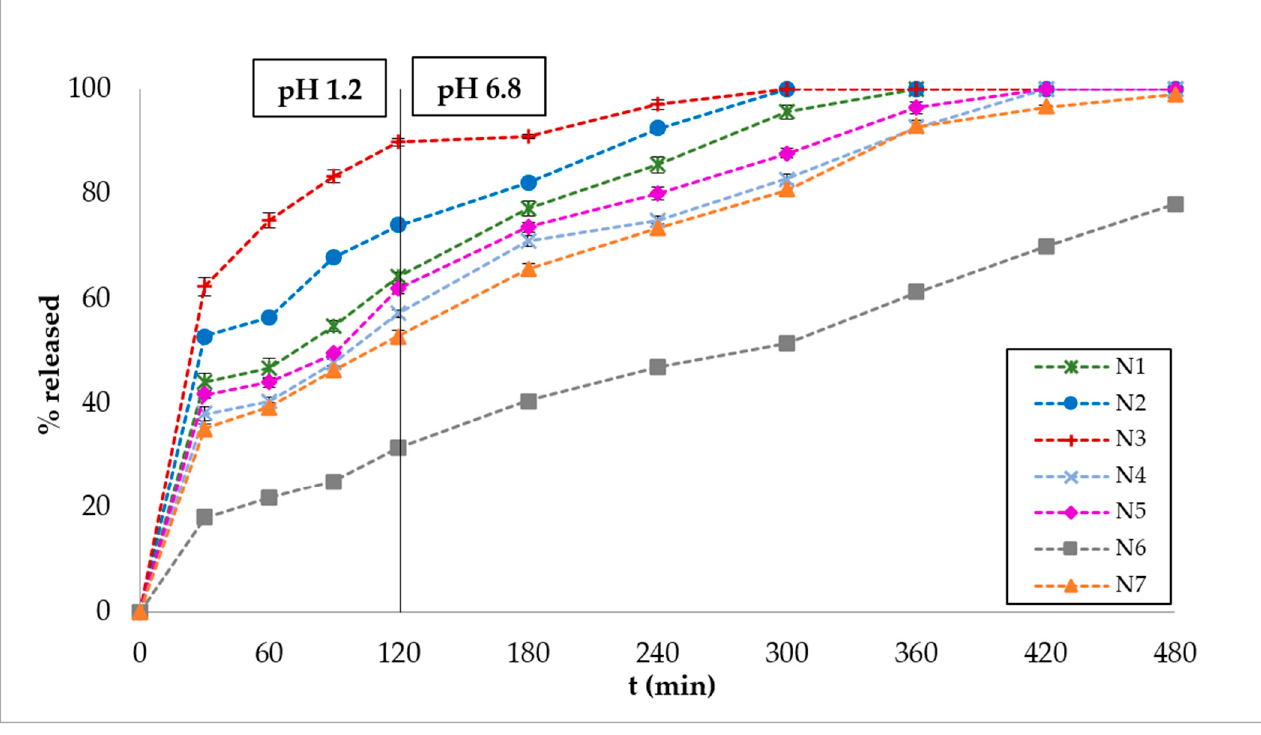
Figure 3. In vitro % release of naltrexone hydrochloride (NTX · HCl) vs. time from different tablet formulations at pH 1.2 (0–120 min) and at pH 6.8 (120–480 min). The results denote the mean value ( n = 6, SD <